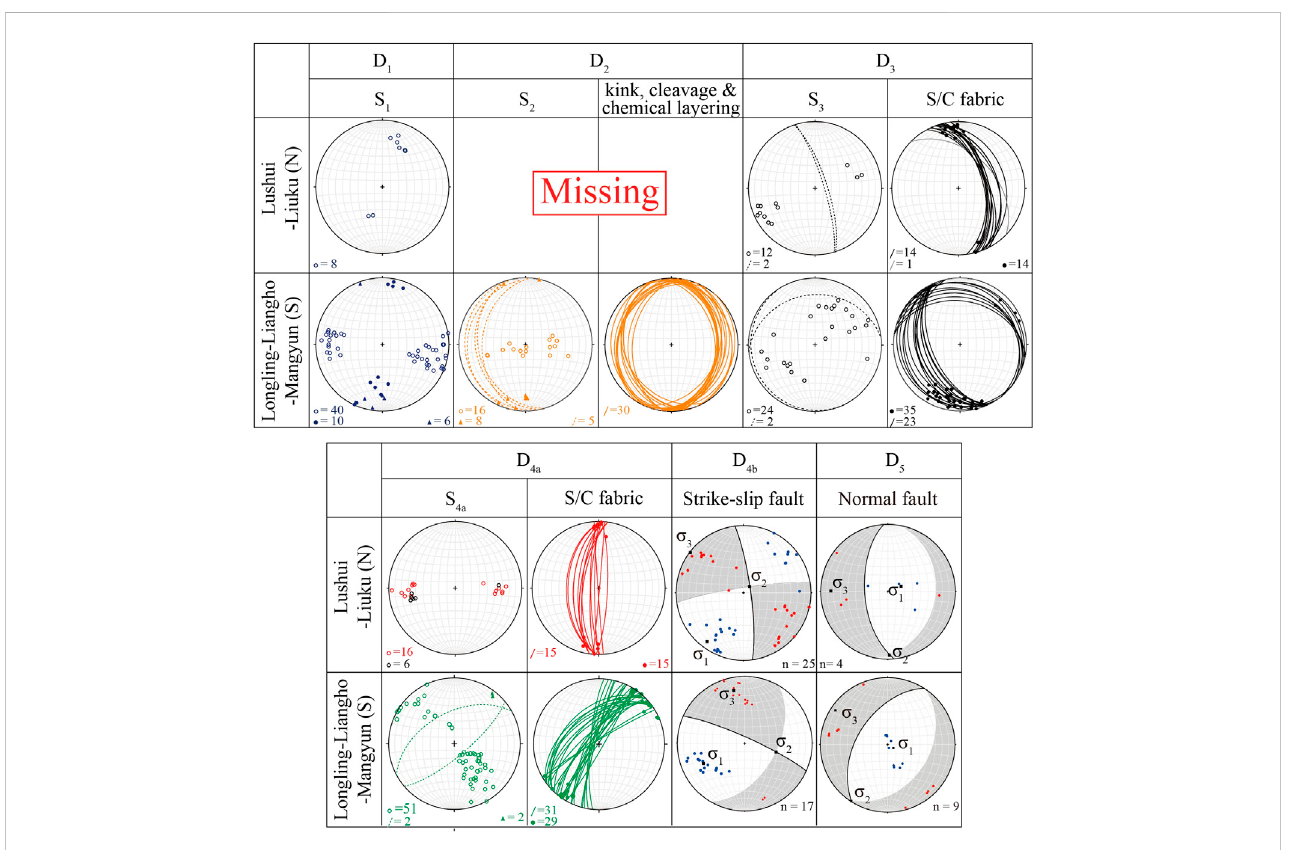
FIGURE 8 Diagram showing southern hemisphere equal-area projection stereonet diagrams of each reconstructed deformation event from both northern (Lushui – Liuku;Chiuetal.,2018)andsouthern(Longling – Liangho – Mangyun;thisstudy)segmentsoftheGaoligongorocline.D 3 ,D 4 ,andD 5 canbecorrelated as thesame events for both northern and southern sections according to thesame structuralstyle andstress pattern. D 2 from thesouthern section, however, cannot be correlated to any deformation events in the northern section. Therefore, we assume that D 2 only affected the southern section. Although D 1 from both sections shows some similarity in the foliation style, we do not consider the correlation to be formed due to too few